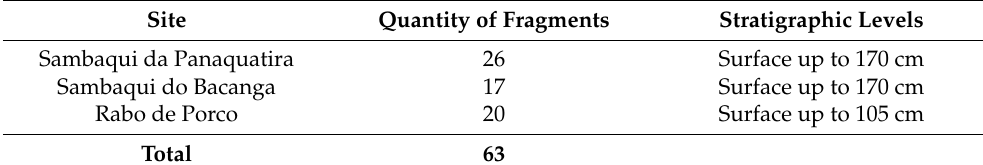
Table 1. Information about fragments.